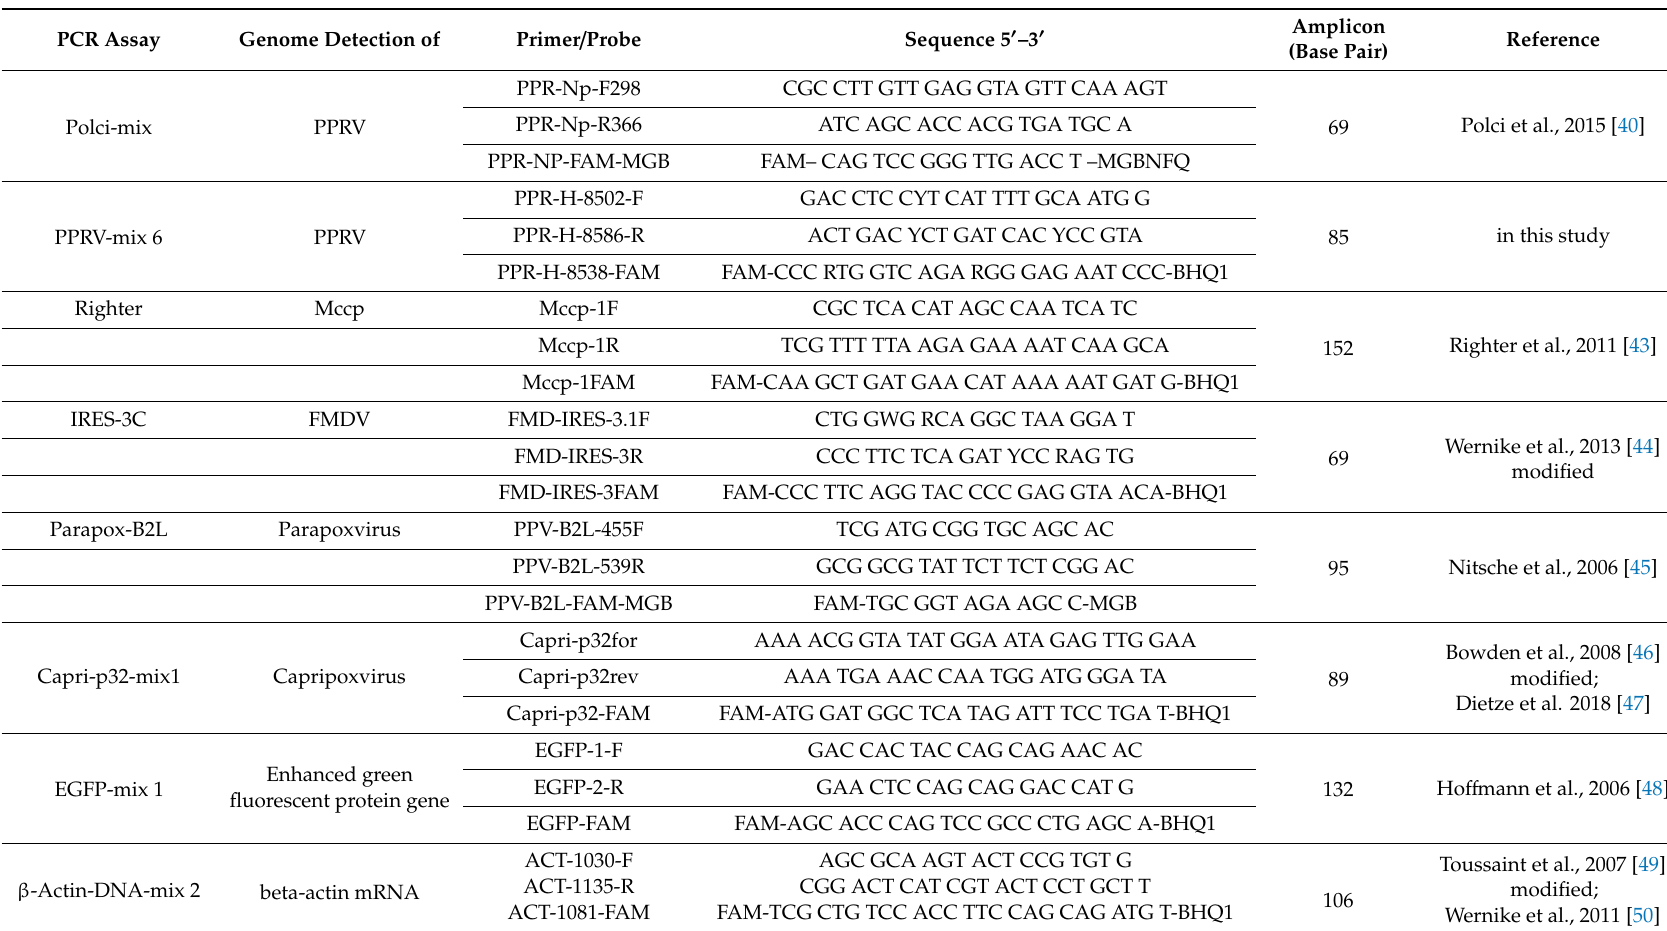
Table 1. Sequences of the primers and probes tested for a high-speed RT-qPCR approach for the detection of PPRV and clinically similar